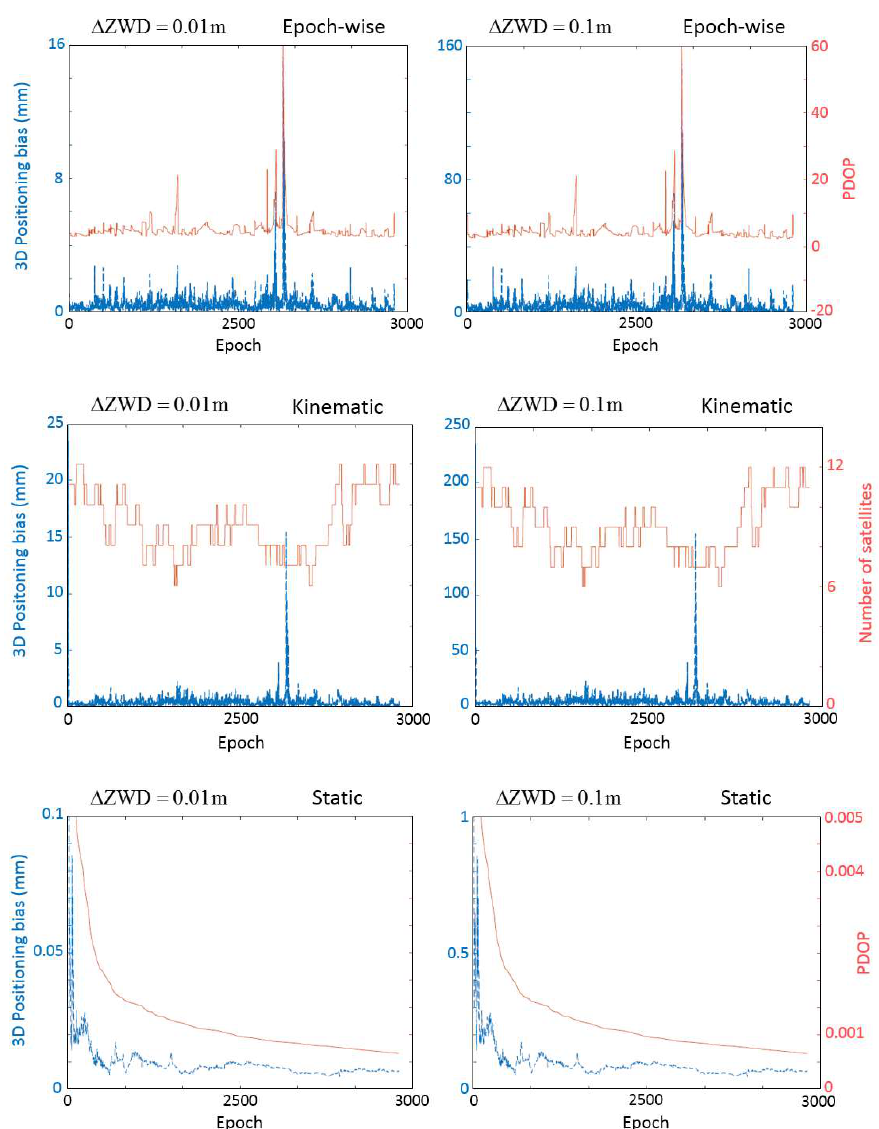
Figure 2. The effect of on the estimated position (blue lines) in different modes and for different ZWD offsets. The orange lines show the position dilution of precision (PDOP)/number of satellites .